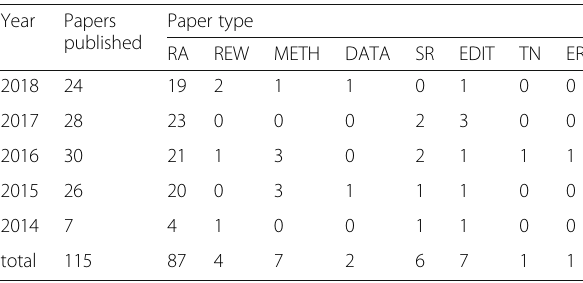
Table 2 Types of papers published in the first five volumes of Geoenvironmental